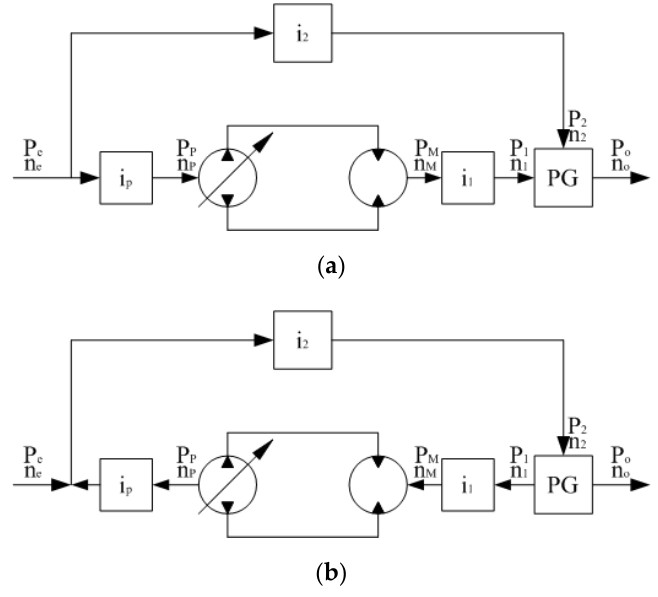
Figure 14. Power transmitting Mode: ( a ) Mode Ⅰ ; ( b ) Mode Ⅱ .